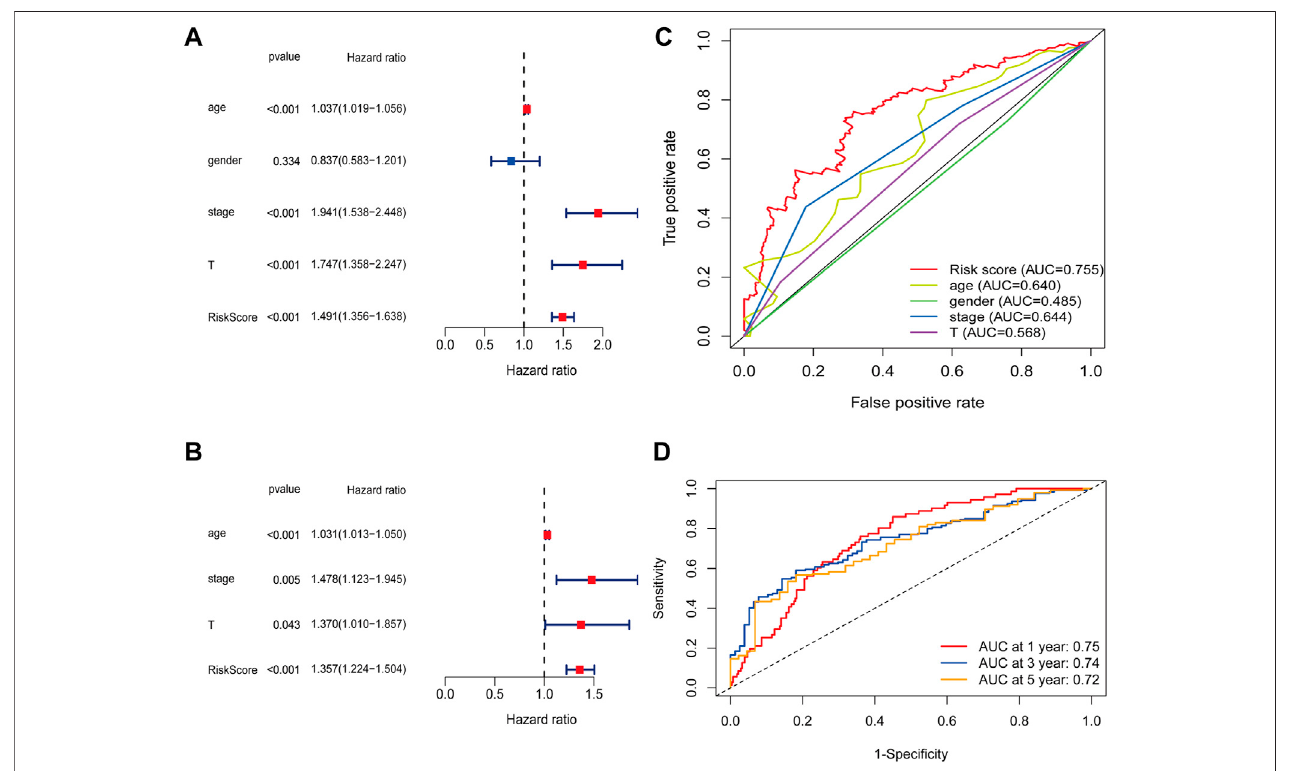
FIGURE4| Theriskscorecanpredictprognosisindependently. (A) UnivariateCOXanalysisand (B) MultivariateCOXanalysisresultsoftheriskscoreandcommon clinical characters. (C) The AUC of risk score and common clinical characters. (D) 1-, 3-, and 5-years ROC curves of the risk score.